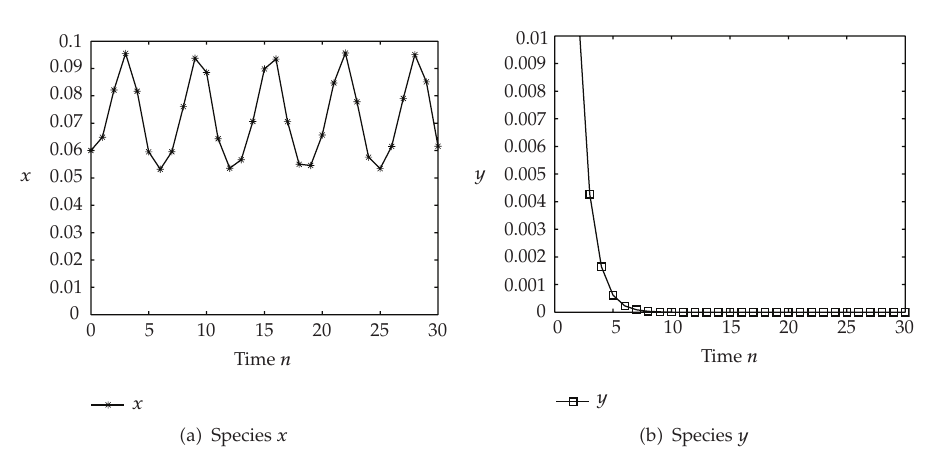
Figure 2: Dynamics behaviors of system (cid:6) 5.2 (cid:7) with initial conditions (cid:6) x (cid:6) 0 (cid:7) ,y (cid:6) 0 (cid:7) ,u 1 (cid:6) 0 (cid:7) ,u 2 (cid:6) 0 (cid:7)(cid:7) T (cid:8) (cid:6) 0 . 06 , 0 . 08 , 0 . 04 , 0 . 02 (cid:7) T .